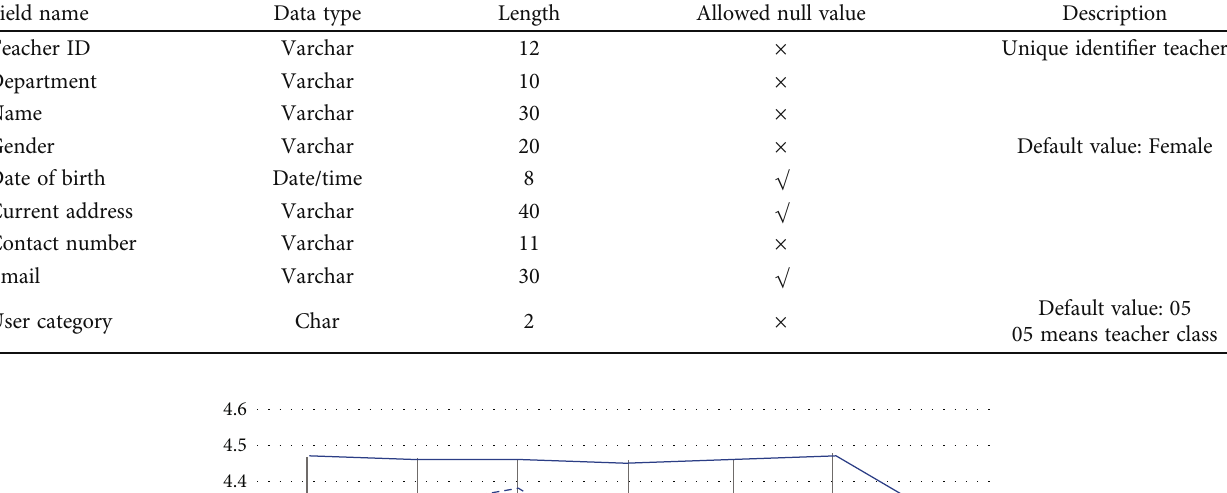
Table 5: Basic information of teachers.